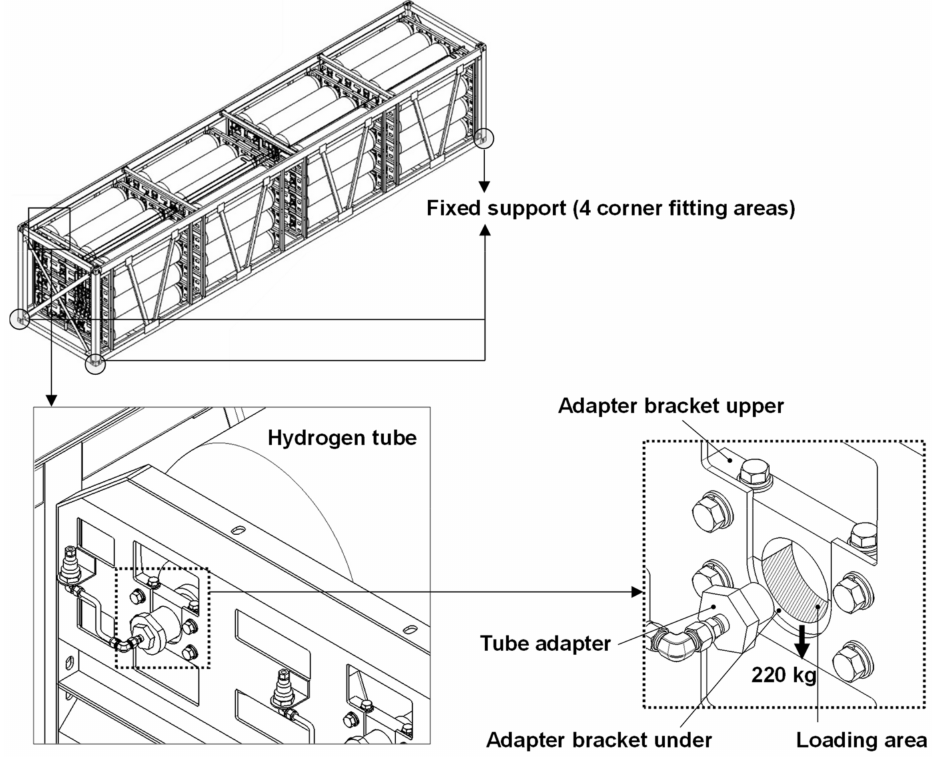
Figure 4. Boundary and loading